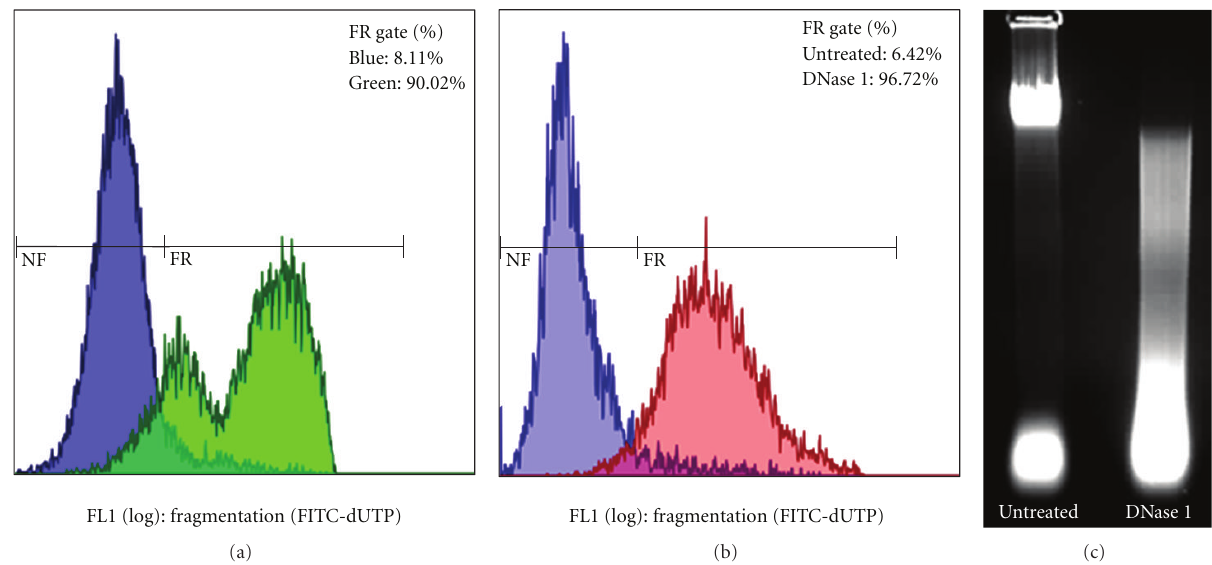
Figure 1: DNA fragmentation as illustrated by the TUNEL assay and agarose gel electrophoresis. Plot regions are denoted as nonfragmented (NF) and fragmented (FR). (a) TUNEL results showing parasites at 5.0% parasitaemia (blue) and parasites at parasitaemia of 7.2%, which failed to progress beyond the ring stage (green), after a decline from a high parasitaemia of > 11%. (b) TUNEL results of untreated parasites (blue) and parasites treated with DNase 1 (red). (c) Agarose gel electrophoresis of genomic DNA from intact untreated (left) and DNase 1-treated (right) parasites showing a smear of DNA